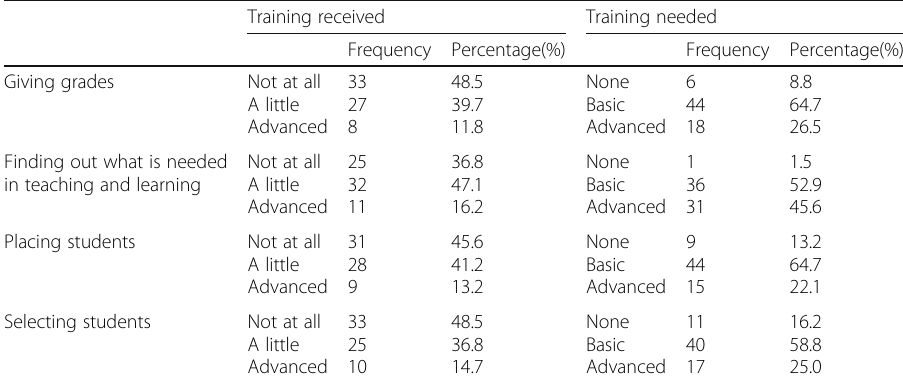
Table 3 Respondents ’ assessment training received and needed in purpose of